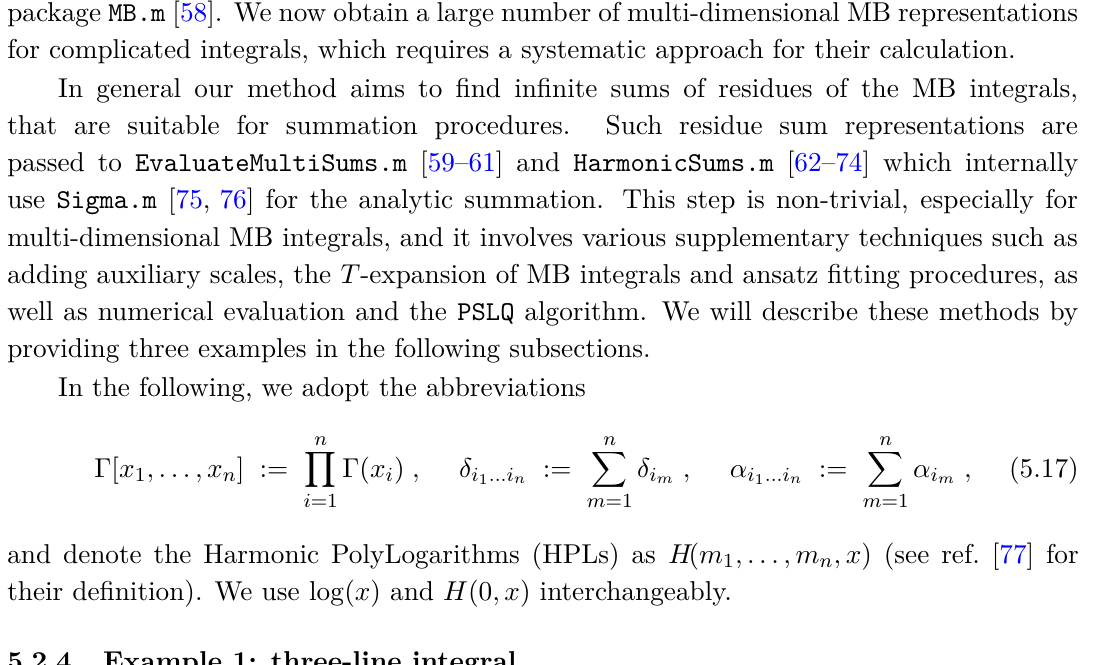
Figure 4 . Three-line sunrise diagram with massless external lines. Solid internal lines represent massive scalar propagators. The dotted external lines indicate that the lines are